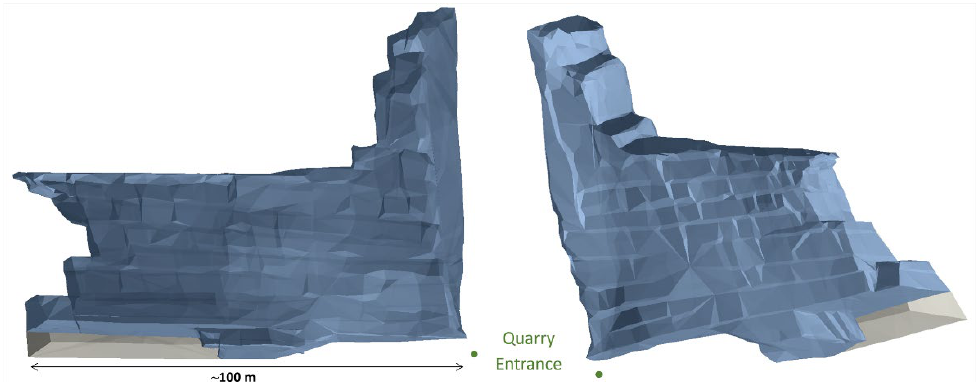
Figure 18. Deviatoric stress ( σ 1 – σ 3 ) of Section S2 calculated in MPa.